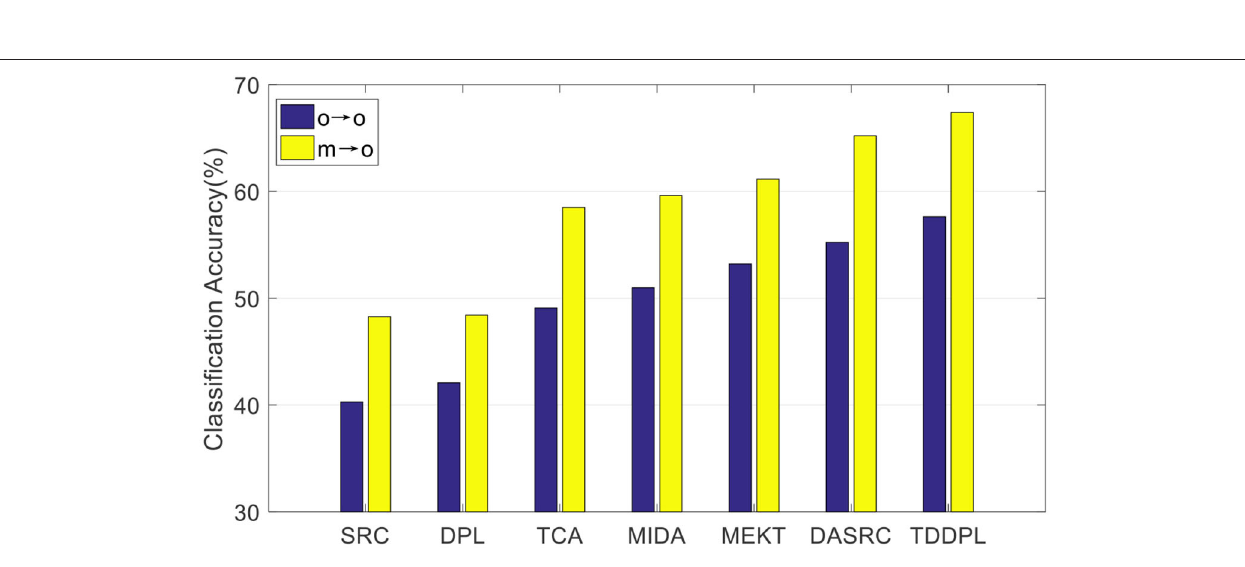
FIGURE 4 | Average classification accuracies on session 3 of the SEED IV